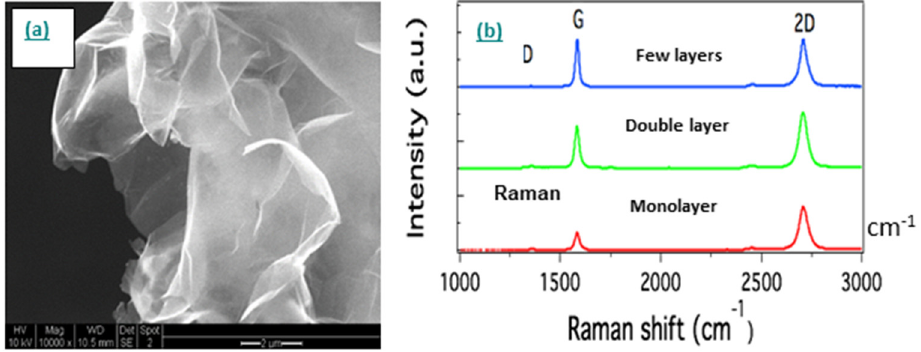
Figure 2. ( a ) Scanning electron microscope (SEM) of 3D graphene pellet; ( b ) Raman spectroscopy of 3D graphene pellet conducted at altered spots on the sample, revealing a different number of graphene layers within the probed